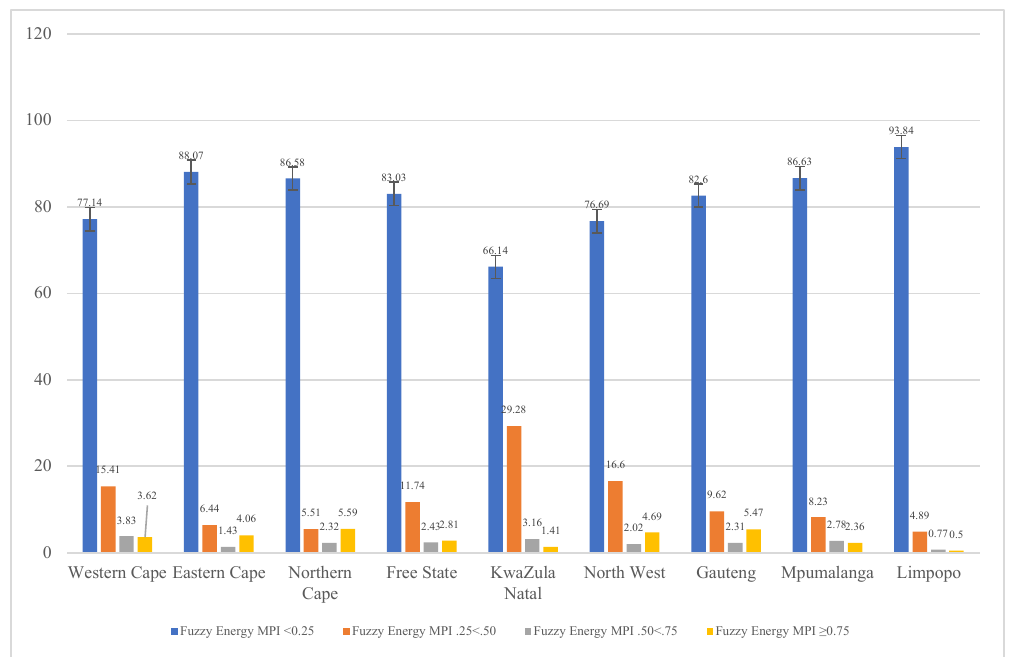
Figure 3. Distribution of fuzzy MEPI across South Africa’s provinces (2019–2022). Source: GHS datasets (2019–2021).